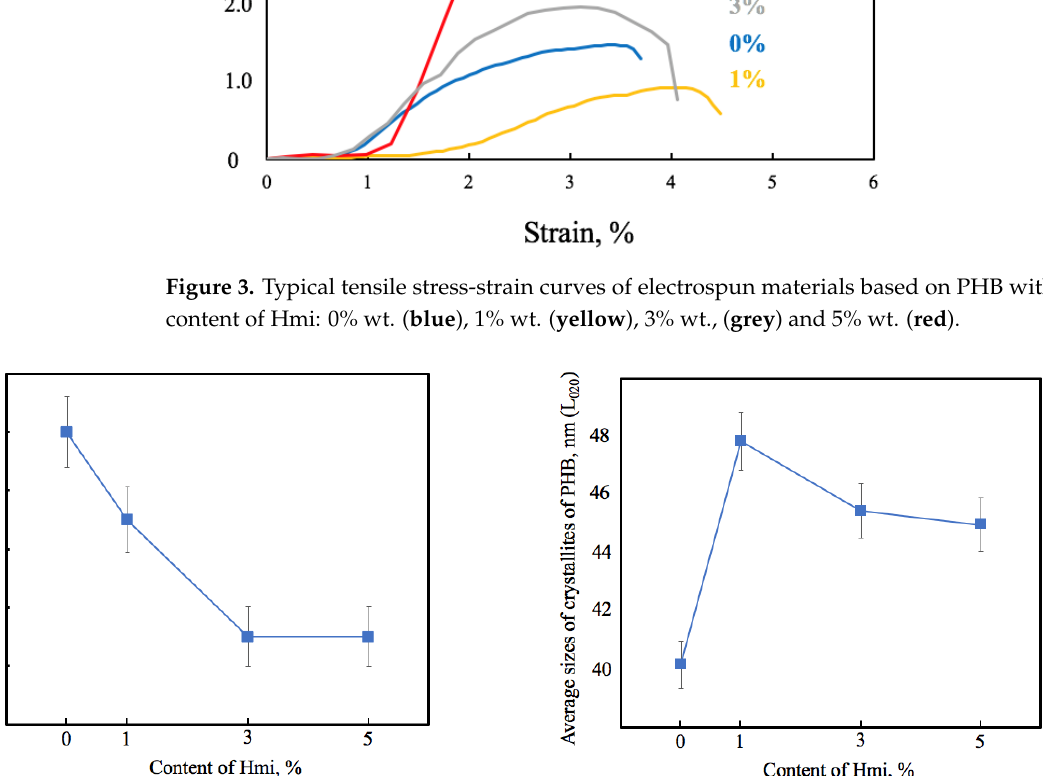
Figure 3. Typical tensile stress-strain curves of electrospun materials based on PHB with different content of Hmi: 0% wt. ( blue ), 1% wt. ( yellow ), 3% wt., ( grey ) and 5% wt. ( red ).